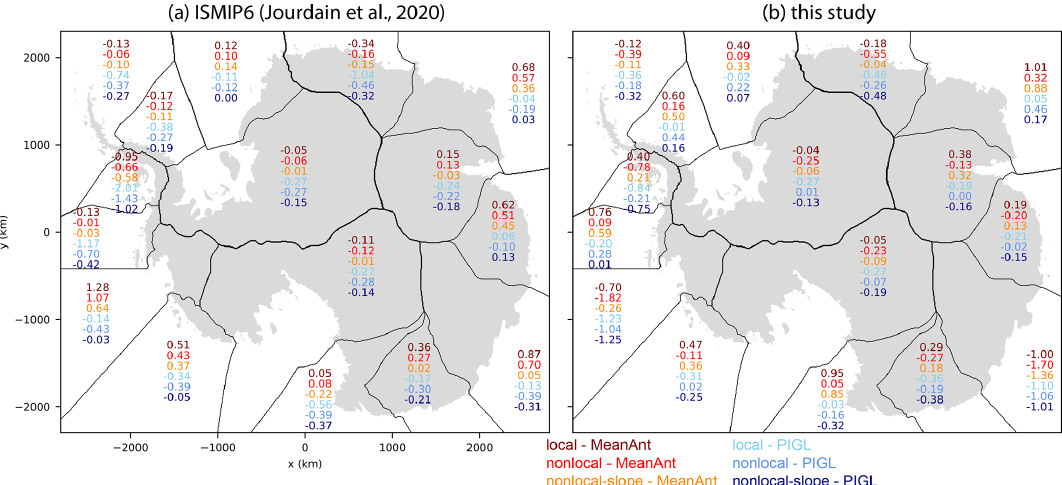
Figure 6. Values of the thermal forcing correction δT sector ( ◦ C) in each of 16 Antarctic sectors for six combinations of melt parameterization (local, nonlocal, and nonlocal-slope) and calibration (MeanAnt and PIGL). (a) ISMIP6 values, calibrated based on sub-shelf melt rates. Values for the local and nonlocal parameterizations were reported by Jourdain et al. (2020); values for nonlocal-slope were computed for this study. (b) Values obtained during CISM spin-ups.